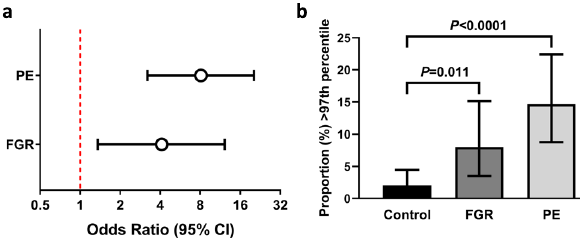
Fig. 5 Circulating maternal levels of FSTL3 at 36 weeks of gestation and adverse pregnancy outcome. a The association between elevated serum FSTL3 (>97th percentile) and PE or FGR (see “ Methods ” for de fi nitions), expressed as odds ratios and 95% con fi dence intervals (95% CI); and b the proportion of samples above 97th percentile (95% CI). This analysis is based on 495 samples (289 controls and 206 cases of which 106 had PE only, 90 had FGR only and 10 had both PE and FGR). The P values were calculated using Fisher ’ s exact test (two-sided) based on the dichotomized percentile matrix. The exact P value between Control and PE is 4.6 × 10 − 6 ( b